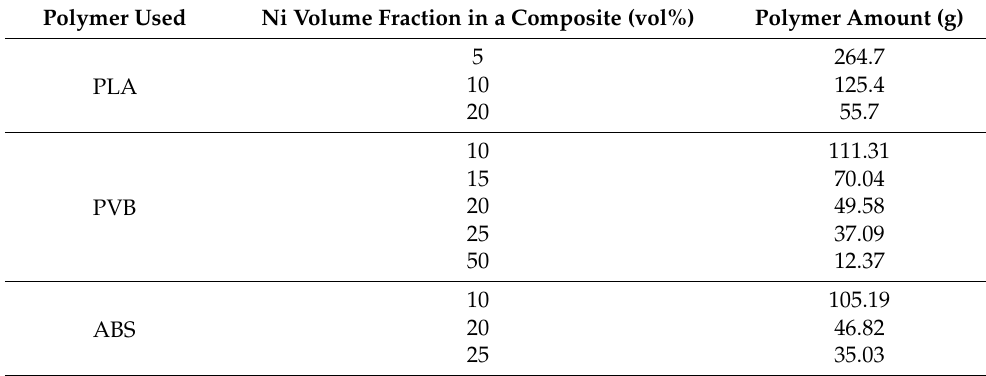
Table 1. Substrates amount used for composite preparation; all samples prepared with 100 g of nickel